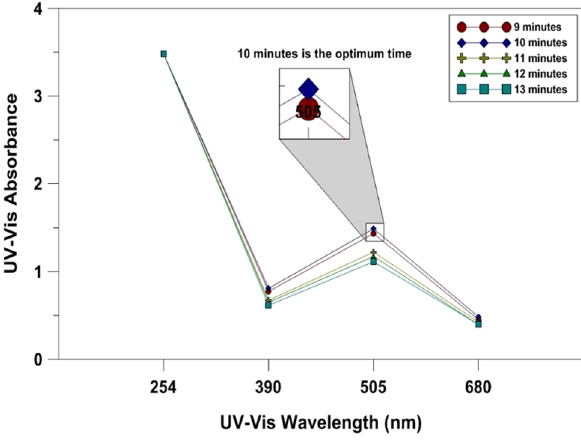
Figure 1: Determination of the optimal